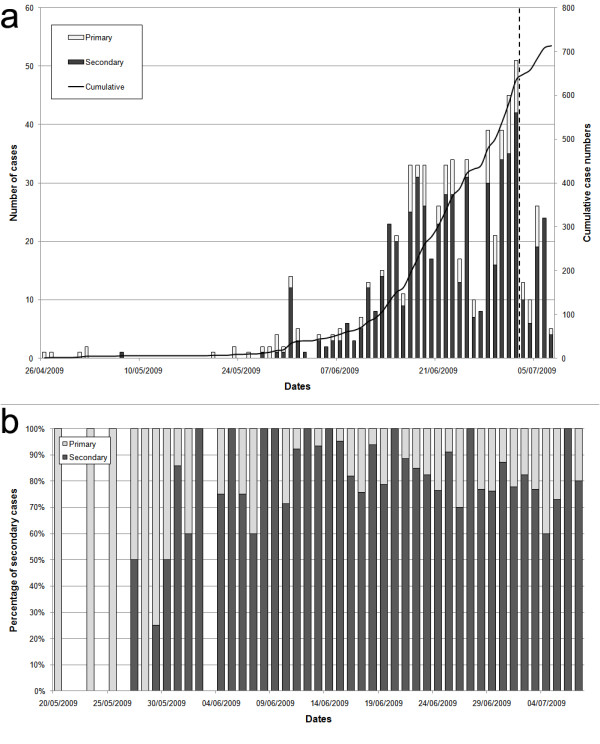
Time series of swine flu in Israel. a- time series of swine flu cases in Israel between the 26/4/2009 and the 7/7/2009, altogether 713 cases. Bars represent the incidences per day (left Y-bar scale) and line the cumulative number (right Y-bar scale). Also marked is the date when the systematic data collection ended (dashed line). b- Percentage of primary versus secondary cases over the epidemic from the 20th of May onwards.